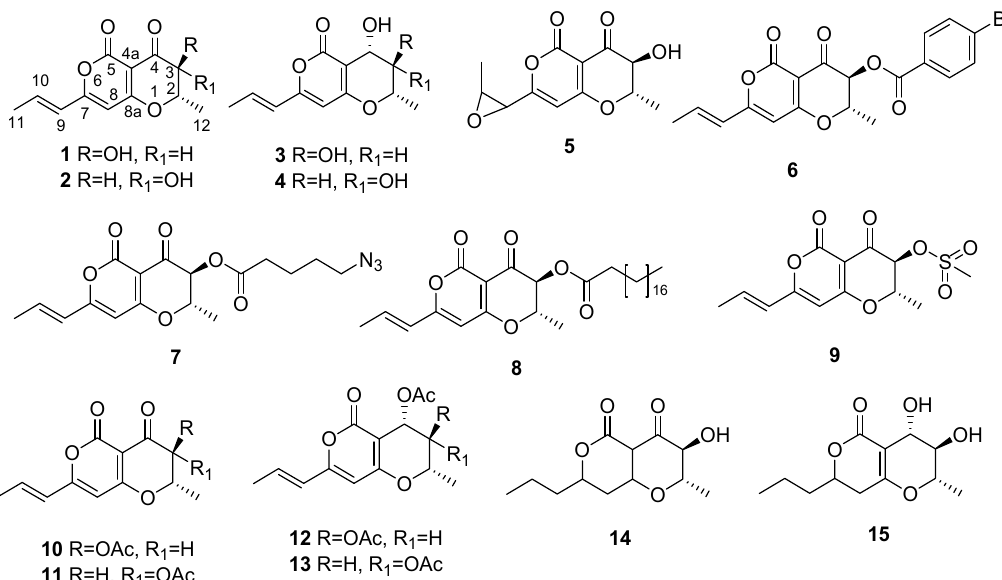
Figure 1. The structures of radicinin ( 1 ), 3- epi -radicinin ( 2 ), radicinol ( 3 ), 3- epi -radicinol ( 4 ), cochliotoxin ( 5 ), radicinin derivatives ( 6 – 10 , 14 , and 15 ), and the acetyl derivatives of 3- epi -radicinin, radicinol, and 3- epi -radicinol ( 11 – 13 , respectively).